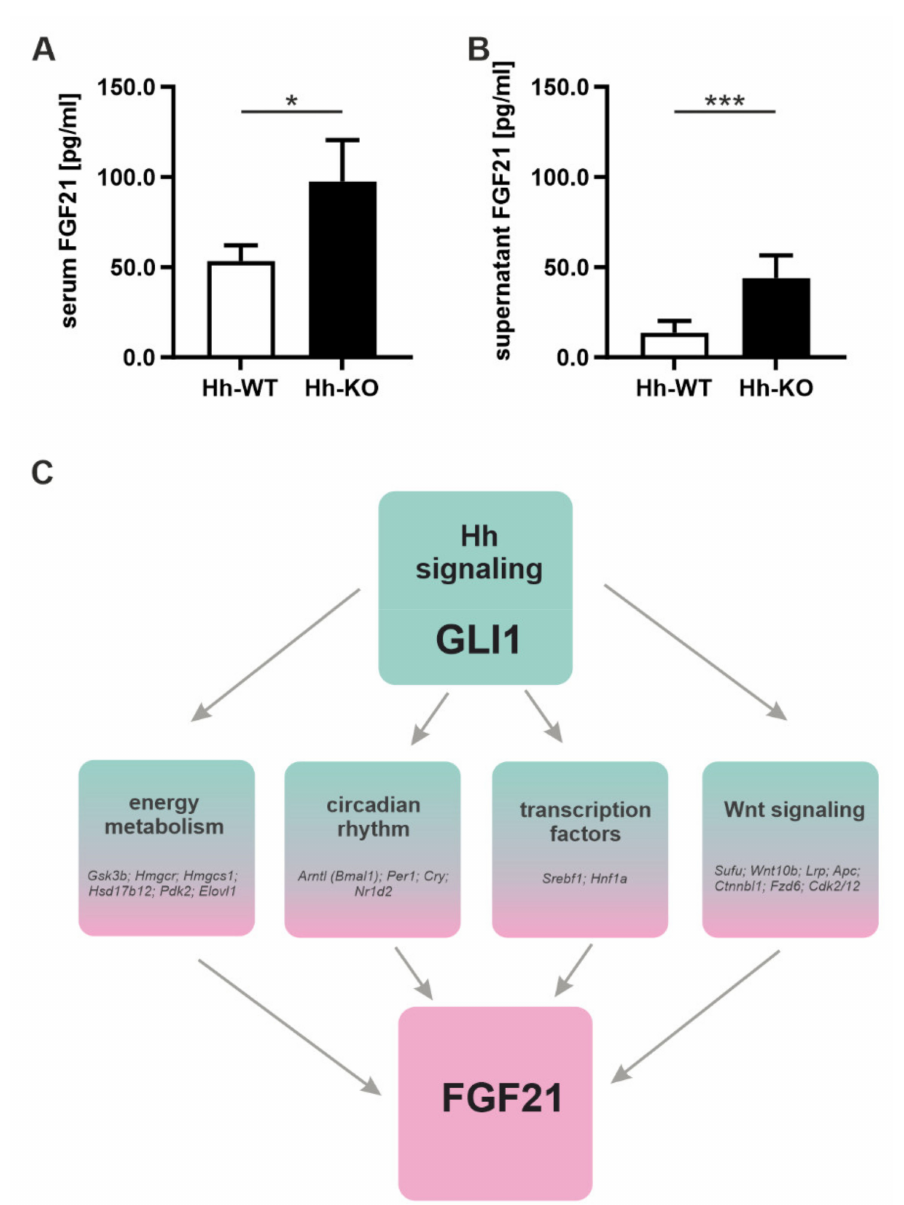
Figure 5. Secretion of FGF21 by hepatocytes. FGF21 was quantified in ( A ) serum and ( B ) hepatocyte supernatants from male Hh-WT and Hh-KO mice by ELISA. Data are plotted as the mean ± standard deviation, n = 3–8, unpaired t-tests with p -values * ≤ 0.05 and *** ≤ 0.001. ( C ) Binding sites of GLI1 in potential regulators of Fgf21 expression identified by ChIP-seq. Numerical values are available in Table